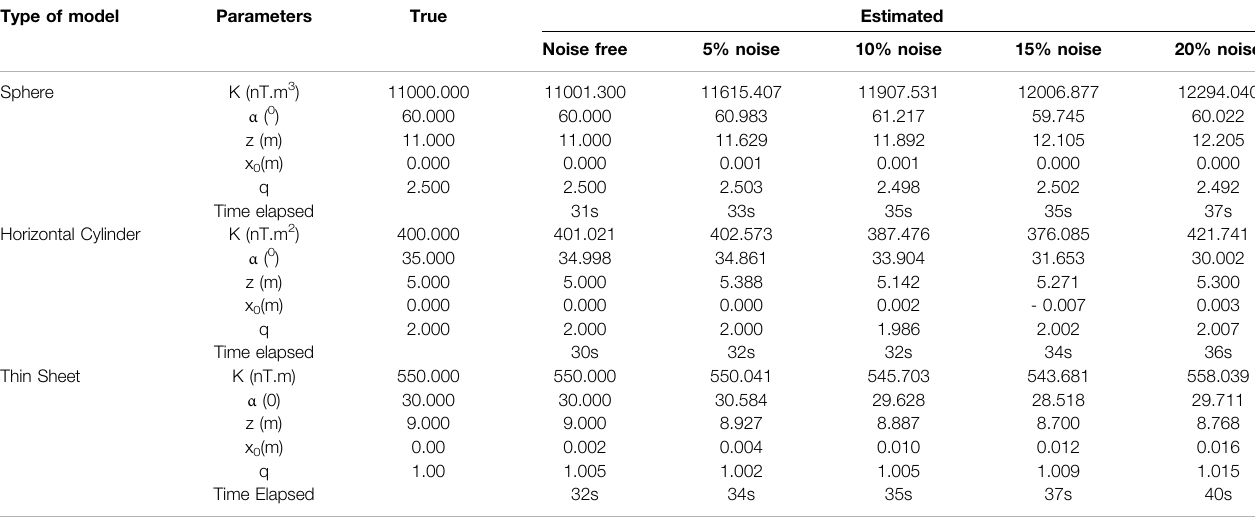
TABLE 3 | Estimated parameters for the example involving synthetically generated noise-free